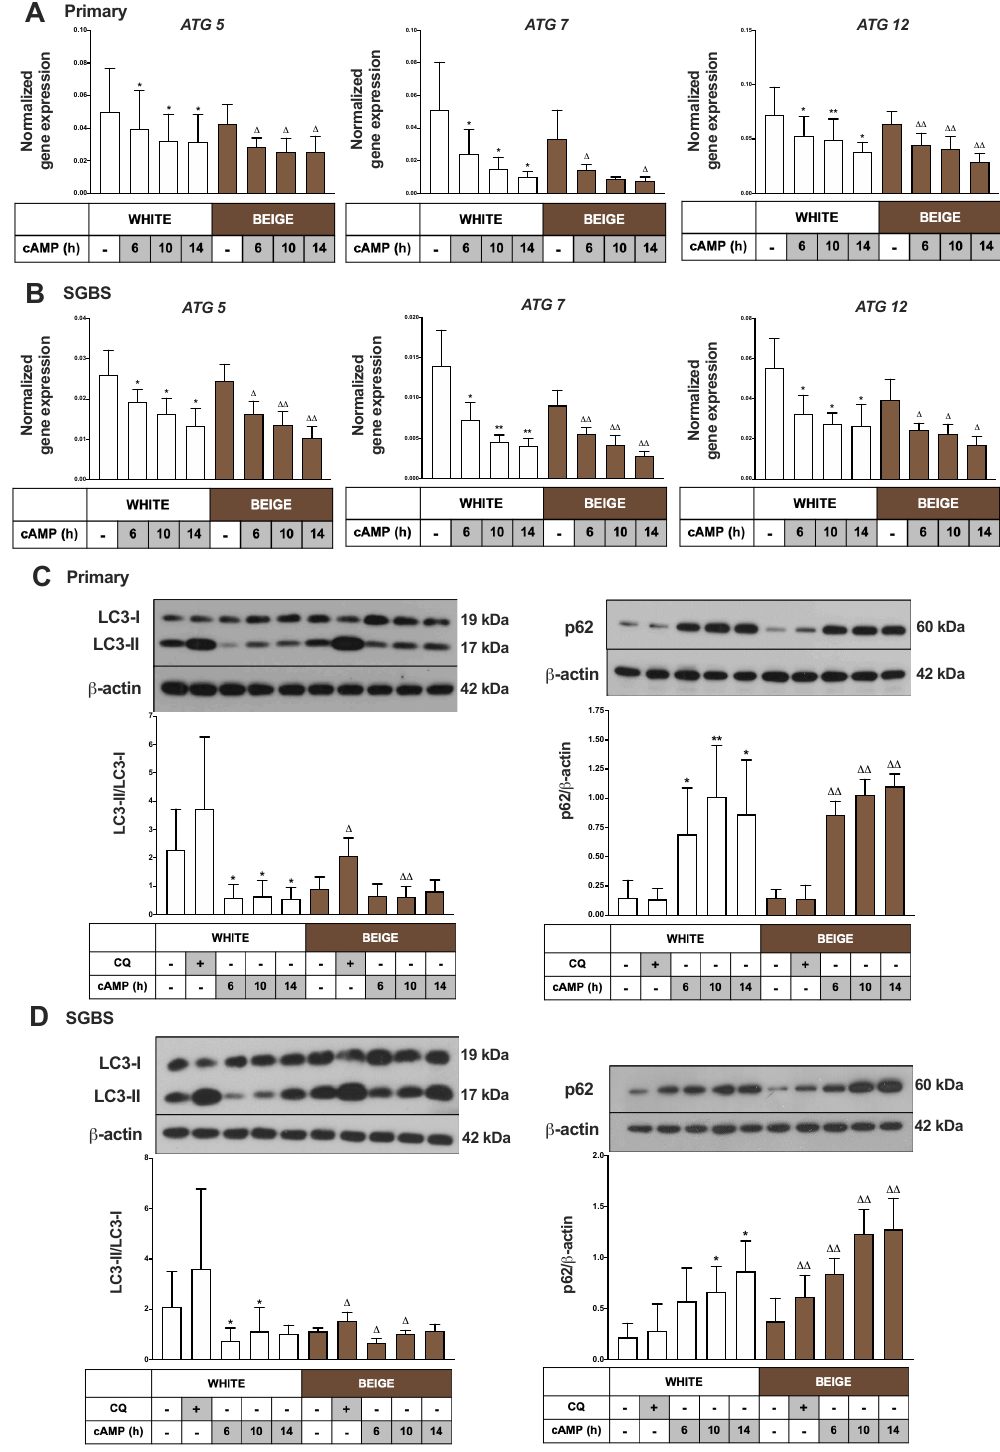
Figure 2. cAMP treatment represses autophagy rate and flux. Adipocytes were di ff erentiated and treated as in Figure 1. Autophagy related (ATG) 5, ATG7 and ATG12 gene expression ( A ) in primary and ( B ) SGBS cells normalized to GAPDH, quantified by RT-qPCR ( n = 5). Representative immunoblots and densitometry analysis of LC3-II / LC3-I protein expression ratio (left) and p62 protein expression (right) normalized to β -actin ( C ) in hASC-derived and ( D ) in SGBS cells ( n = 5). Results are expressed as mean ± SD. Statistics: two-tailed paired student t -test; * p < 0.05; ** p < 0.01; * significant as compared to white untreated sample; (cid:52) p < 0.05; (cid:52)(cid:52) p < 0.01; (cid:52) significant as compared to beige untreated